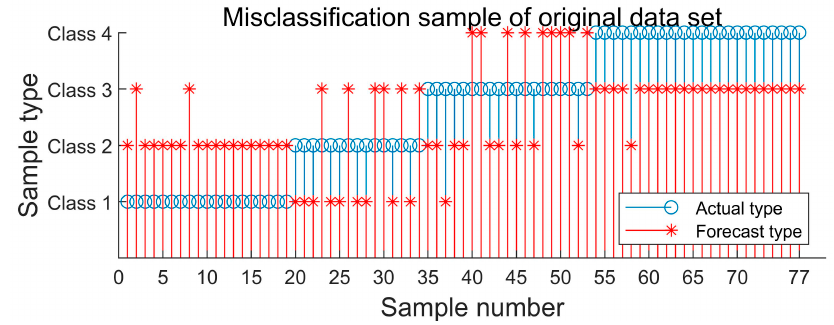
Figure 12. Classification results of misclassified samples in one-vs-all classification SVM.